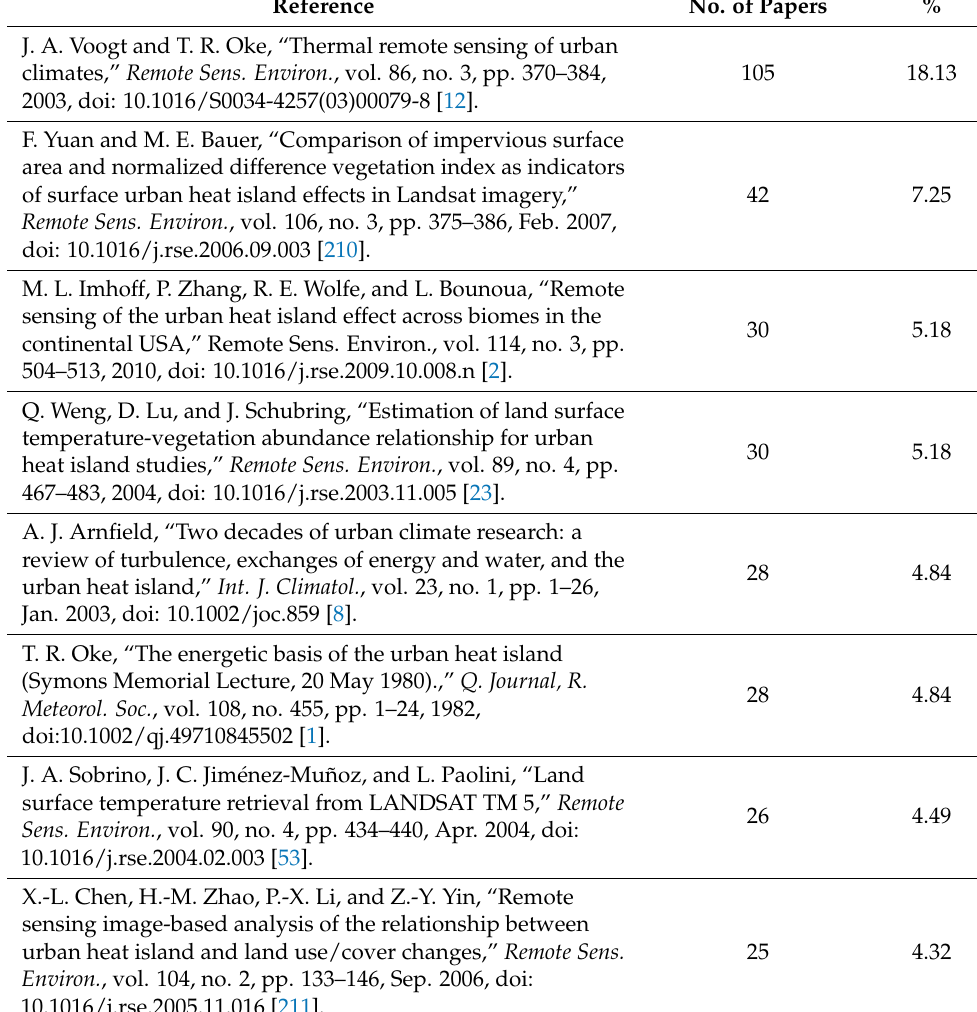
Table 17. Eight most recurrent bibliographic references in the